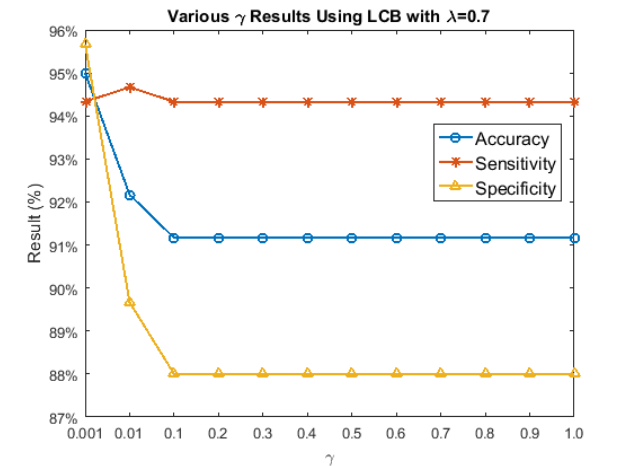
Figure 12. Various γ results for left cheek block (LCB).